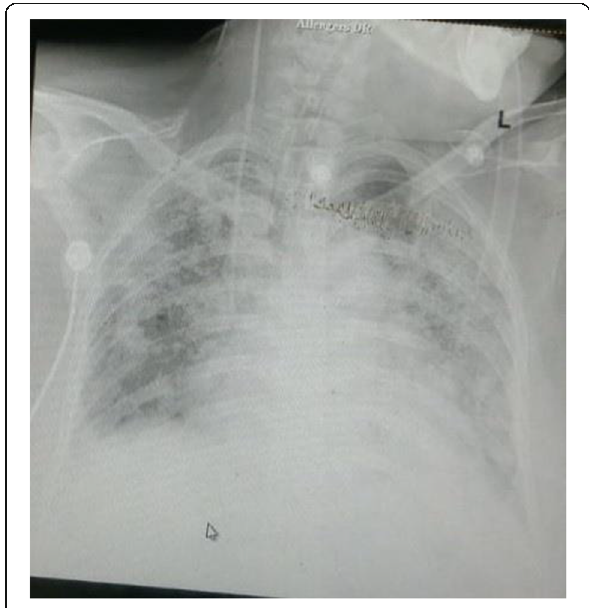
Fig. 1 Chest X-ray on POD6 showing acute congestive cardiac failure with